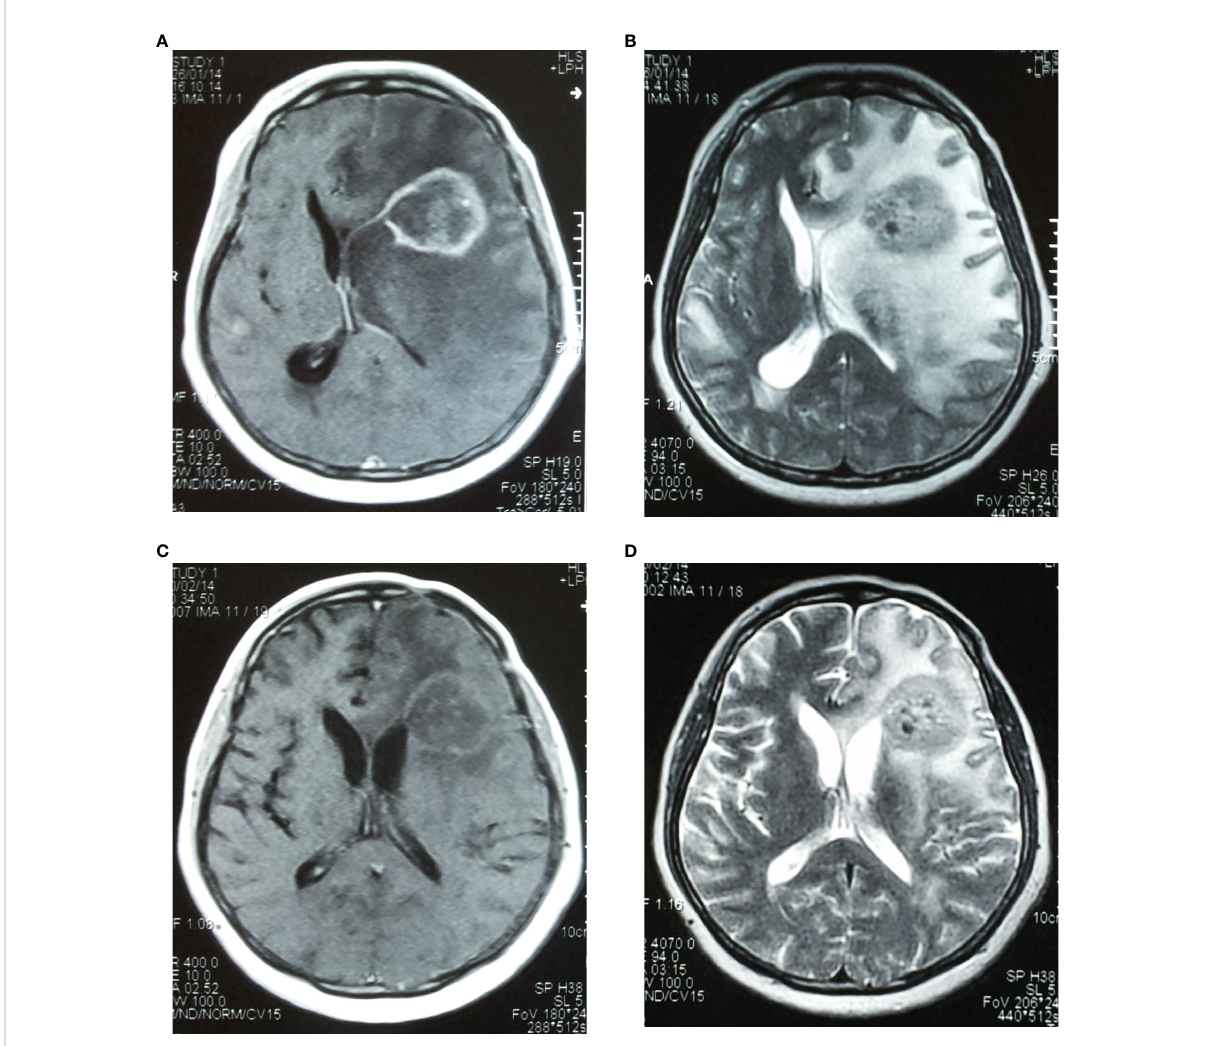
FIGURE 4 A case of brain metastasis derived from colon cancer with radiation-induced brain necrosis in the left frontal lobe that was then treated with 5 mg/kg bevacizumab. (A) Before treatment, MRI T1 showed enhanced areas of brain necrosis; (B) Before treatment, MRI T2 showed obvious perifocal oedema. (C, D) Two weeks after treatment, the area of oedema was obviously decreased, and the quality of life of the patient was signi fi cantly